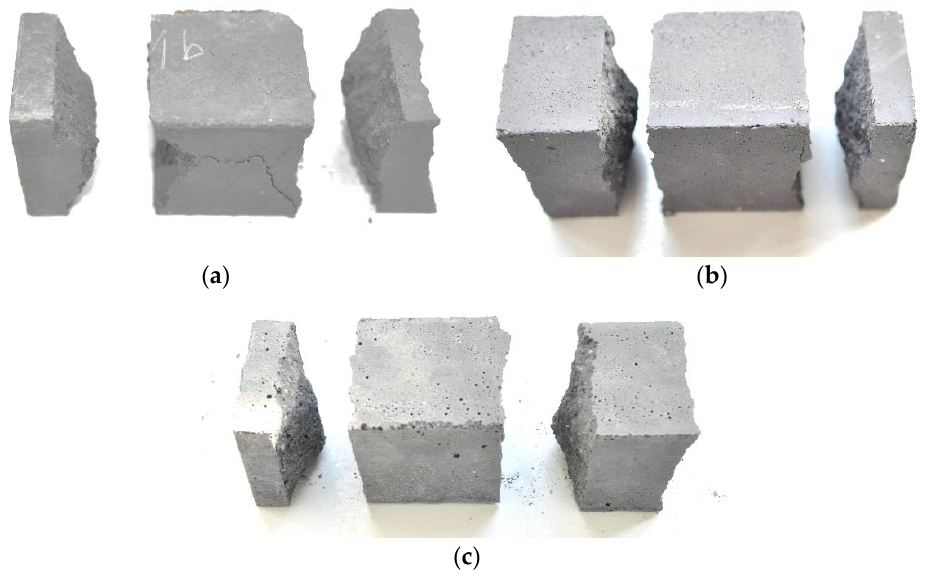
Figure 4. Examples of failure after the compression test of semi-beam samples made with the use of: ( a ) 4 L of mixing water; ( b ) 4.5 L of water; ( c ) 5 L of water.